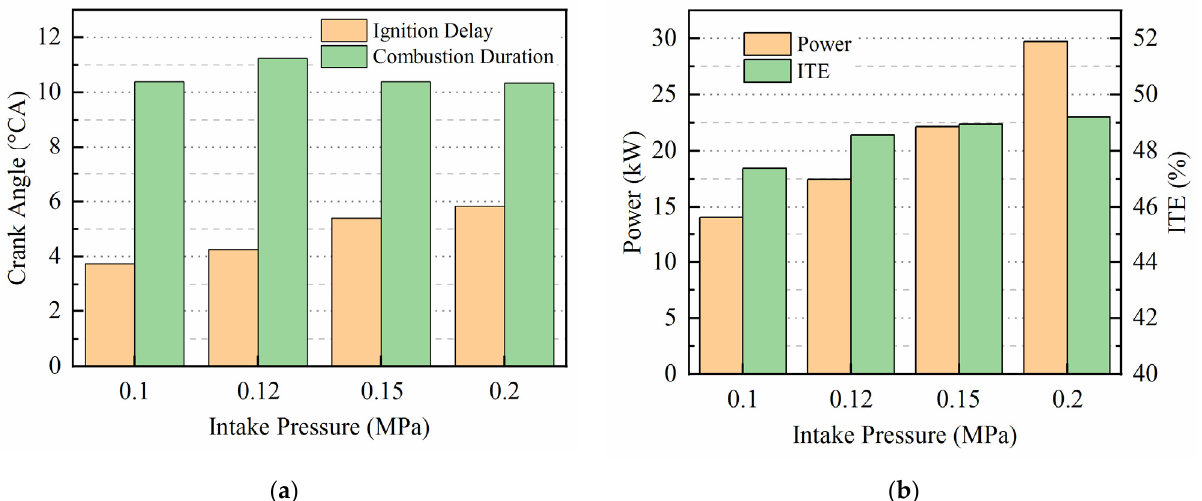
Figure 7. In-cylinder pressure and pressure rise rate ( a ) and heat-release rate curve ( b ) for different intake pressures [47].